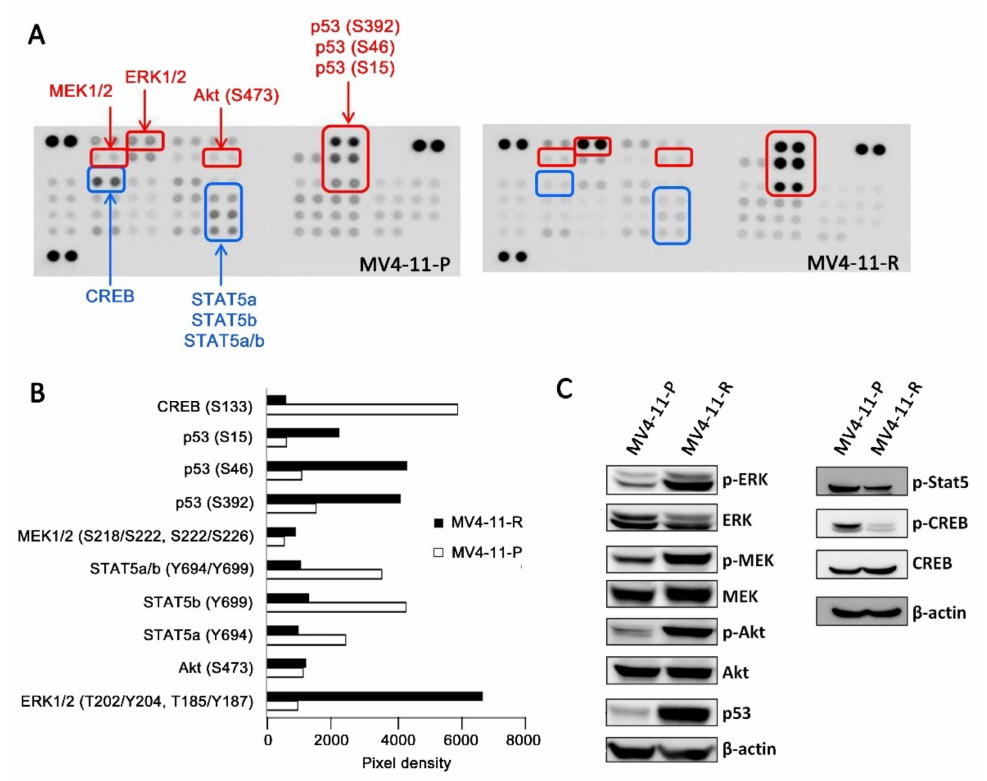
Figure 2. Differential kinase phosphorylation was observed between MV4-11-P and MV4-11-R cells. ( A ) Human phospho-kinase array blots showed increased (shown in red) and decreased (shown in blue) phosphorylation of multiple kinases in MV4-11-R compared with MV4-11-P. Spots for each phospho-kinase antibody are in duplicate. ( B ) Average pixel densities of duplicate spots on the human phospho-kinase array blots were analyzed using ImageJ. ( C ) Cell lysates of MV4-11-P and MV4-11-R were analyzed for selected total/phosphorylated kinases. Representative Western blots of three independent experiments are